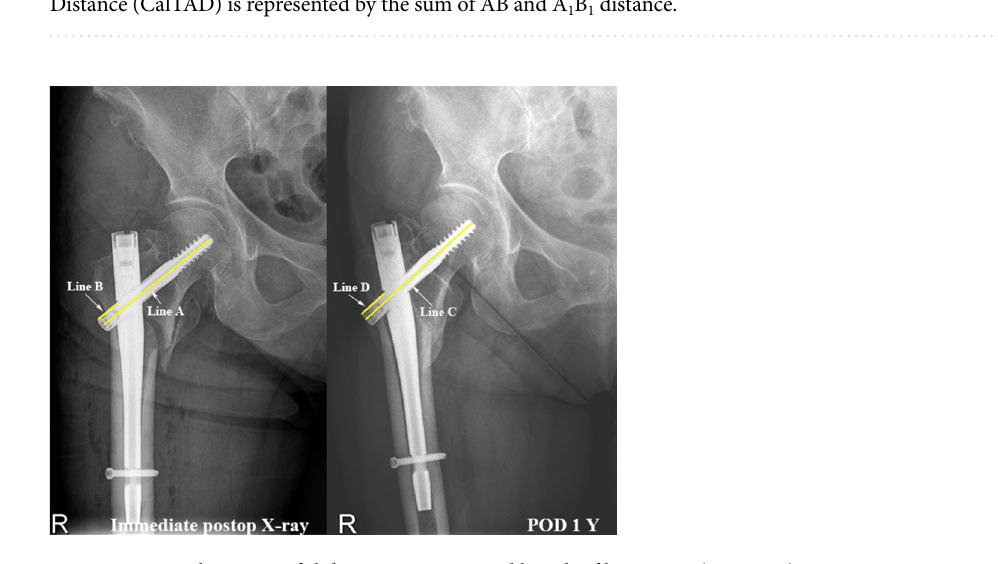
Figure 6. Actual amount of sliding in mms = Actual length of lag screws